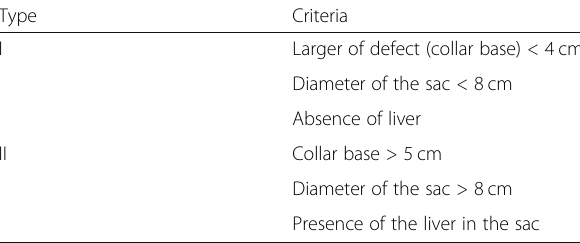
Table 3 Omphalocele Aitken classification